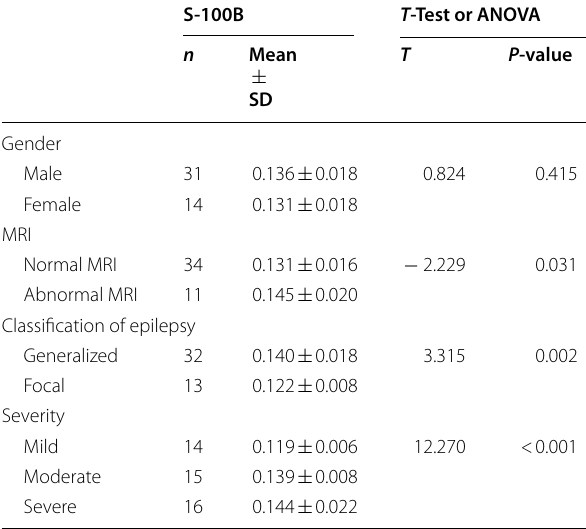
Table 3 Correlation statistics of S-100B protein levels in patient group